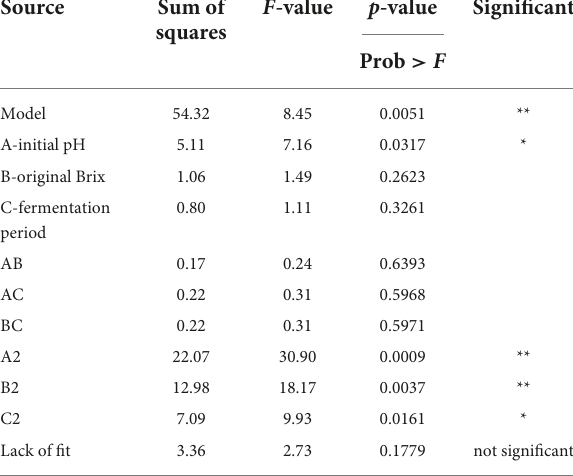
TABLE 5 Analysis of variance (ANOVA) for response surface quadratic model for the optimization of β -damascenone production. F -value p -value Source Sum of squares